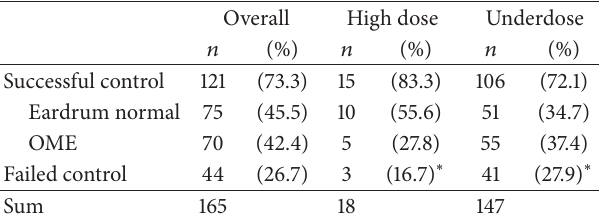
Table 2: Treatment outcome of acute otitis media.